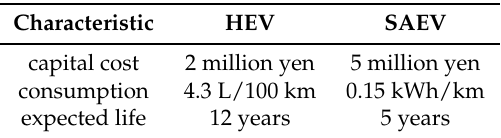
Table 2. Transport mode characteristics.